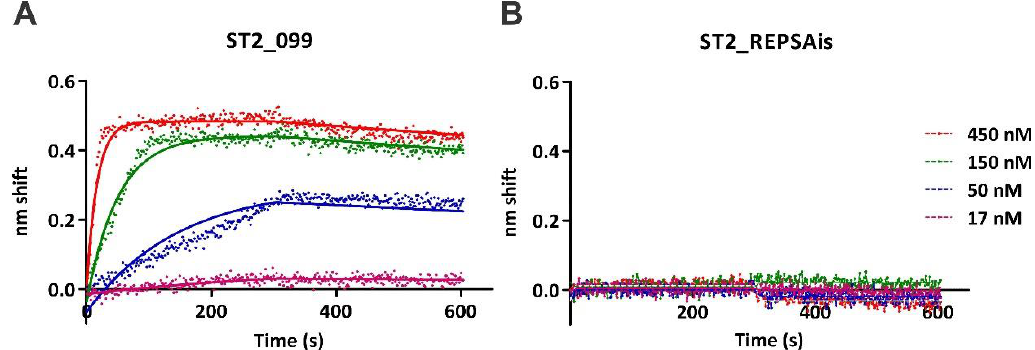
Figure 5. Biolayer interferometry analysis of TTHB099 binding to DNA. Shown are raw traces (dots) and best-fit lines of TTHB099 binding to ( A ) ST2_099 consensus DNA and ( B ) ST2_REPSAis control DNA TTHB099. Concentrations investigated include 450 nM (red), 150 nM (green), 50 nM (blue), and 17 nM (magenta).